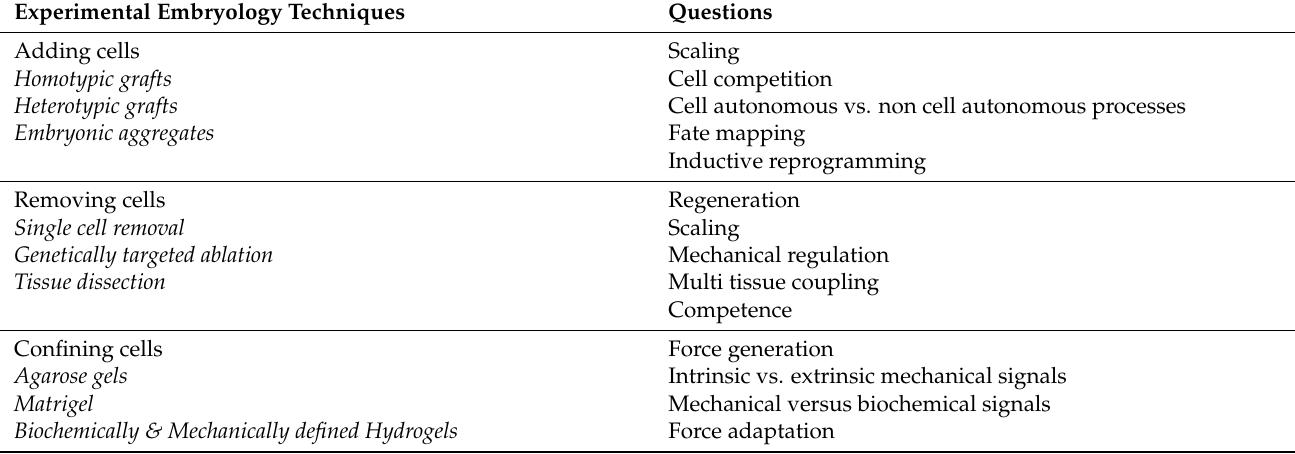
Table 1. Experimental embryology techniques and examples of relevant biological questions that they can help to elucidate.